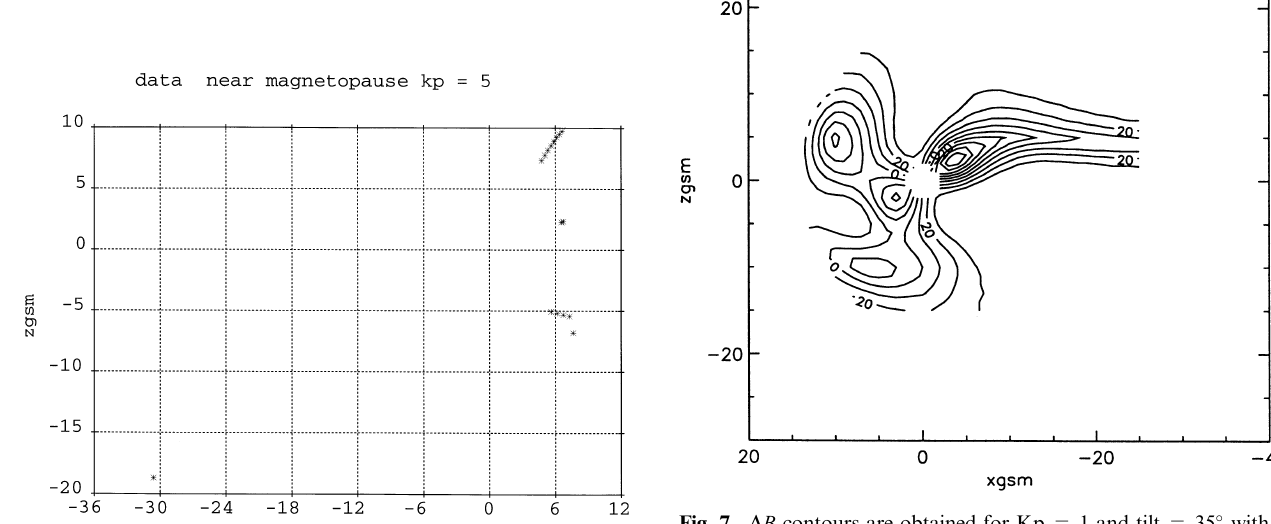
Fig. 7. D B contours are obtained for Kp = 1 and tilt = 35 (cid:14) with a 10 nanoteslas step. In the ring current region the depression is around (cid:255) 30 nanoteslas in the day side and (cid:255) 50 nanoteslas in the night side. Negative bays are obtained near the cusps while positive contours are observed near the